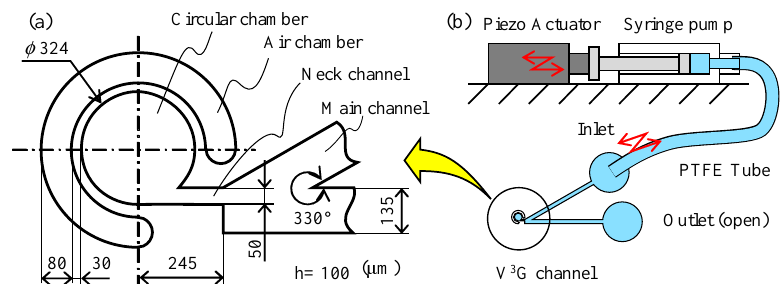
Figure 4. Design of the microfluidic channel and schematic diagrams. ( a ) Channel dimensions. ( b ) The flow is driven by a piezo actuator through a syringe